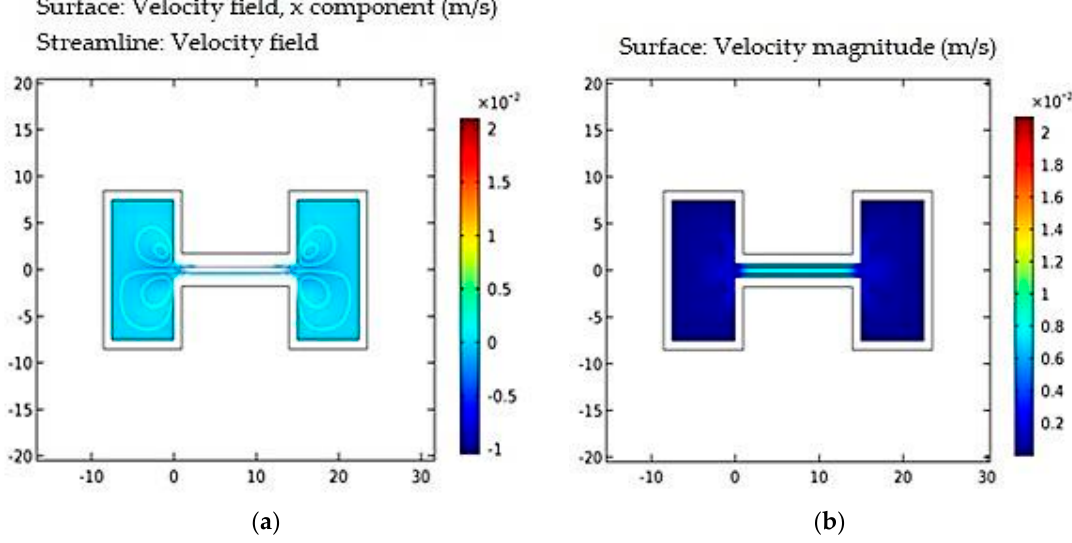
Figure 3. ( a ) Streamline velocity field vs. channel length; and ( b ) velocity magnitude vs. channel length.